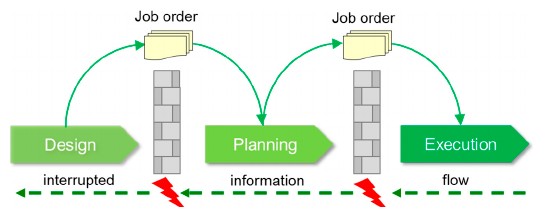
Figure 2. Traditional planning and construction.